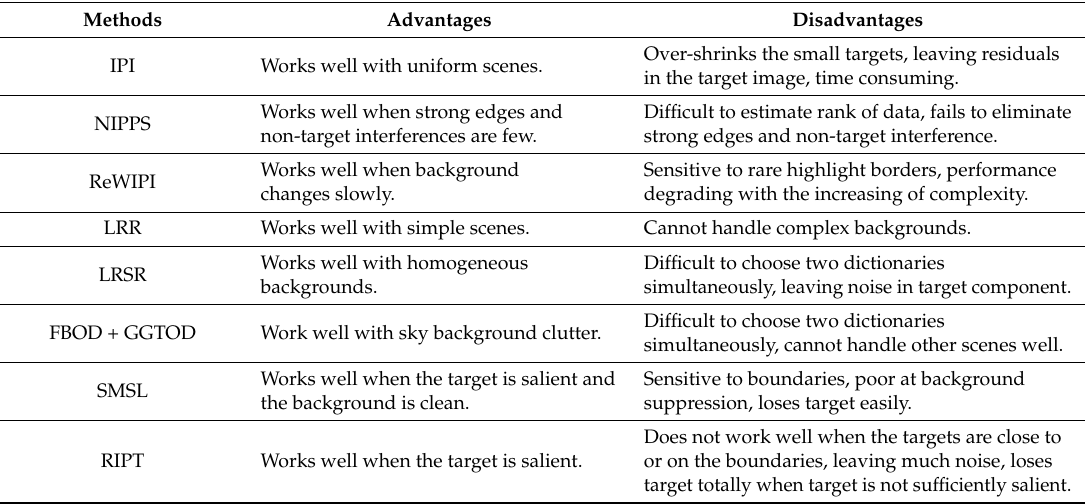
Table 1. Characteristics of typical methods based on target and background separation.